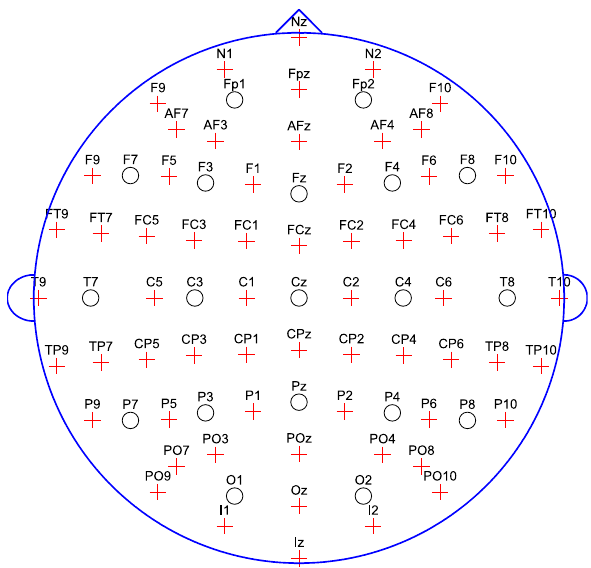
Figure 5. The electrode arrangement of the International 10-20 method and the International 10-10 method. The circles show the electrodes defined by the International 10-20 method. The circles and the crosses show the electrodes defined by the International 10-10